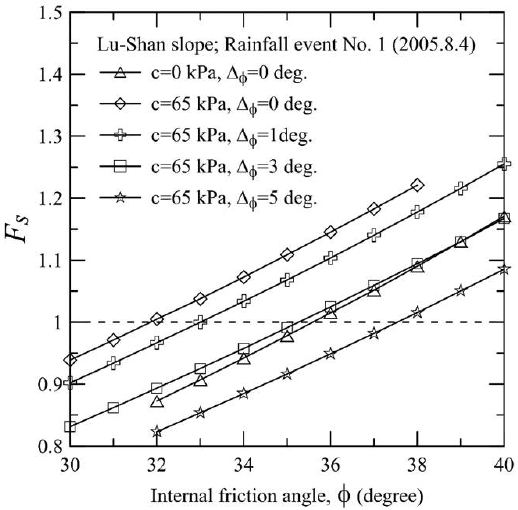
Figure 18. Results of back-analyses for stress-related parameter φ obtained using various values of R f and n .